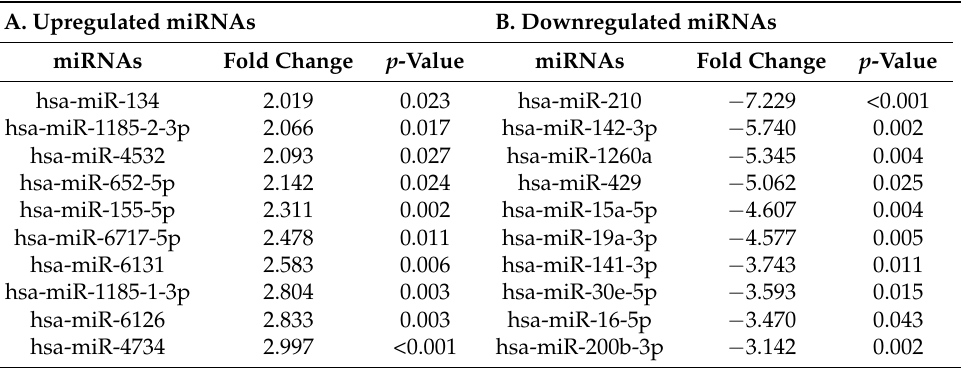
Table 1. MiRNAs significantly upregulated (A) or downregulated (B) by more than 2-fold in cervical squamous cell carcinoma compared with normal